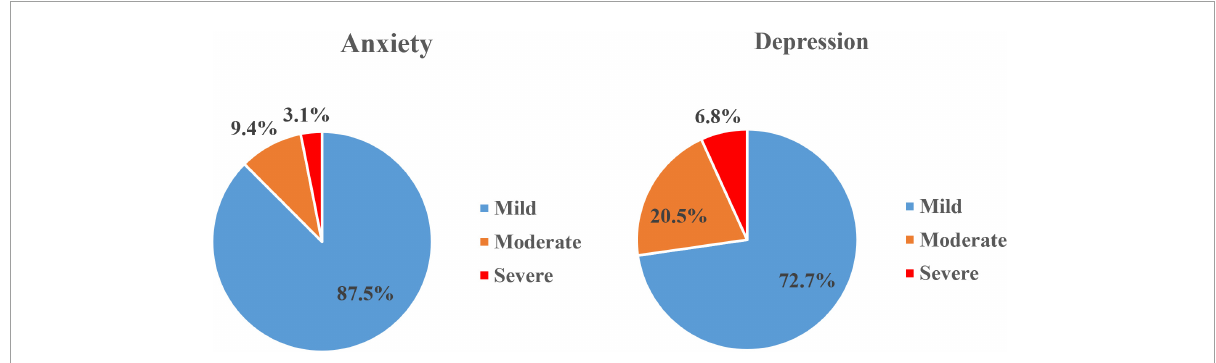
FIGURE1 The distribution of levels of severity on depression and anxiety (prevalence of depressive and anxiety symptoms based on a cutoff score of 53 on SDS and 50 on SAS, respectively. Of 201 participants, 44 participants self-reported with mild-severe depressive symptoms and 32 participants self-reported with mild-severe anxiety symptoms).